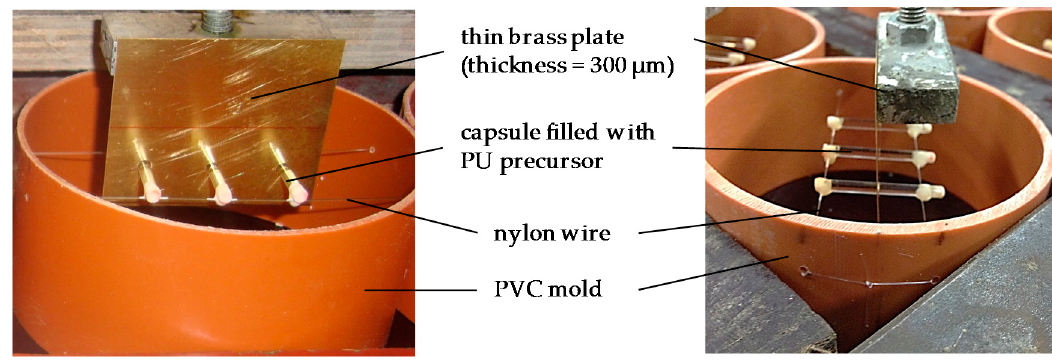
Figure 1. Preparation of self-healing concrete samples.